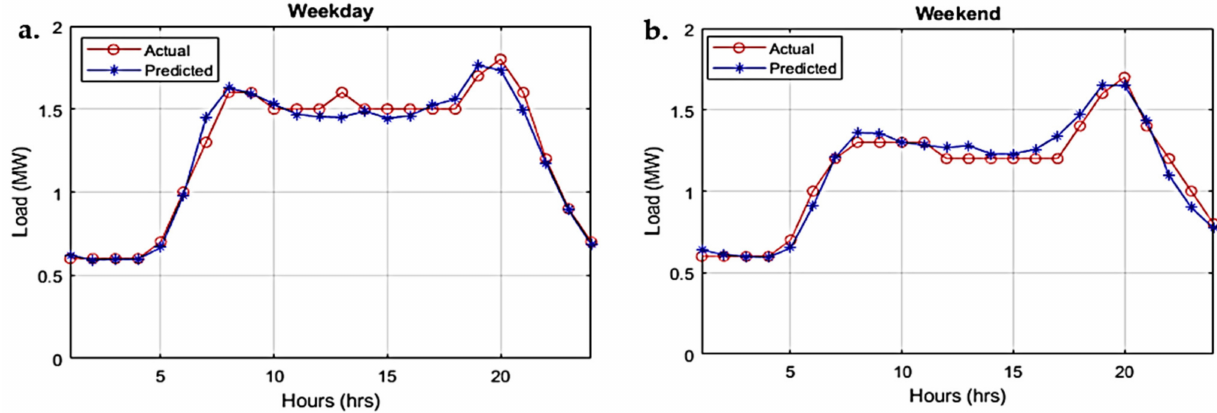
Figure 12. Actual vs. predicted forecasts achieved by the ANN models with ( a ) a double-layer 16 × 16 node structure and ( b ) a single-layer 8 node